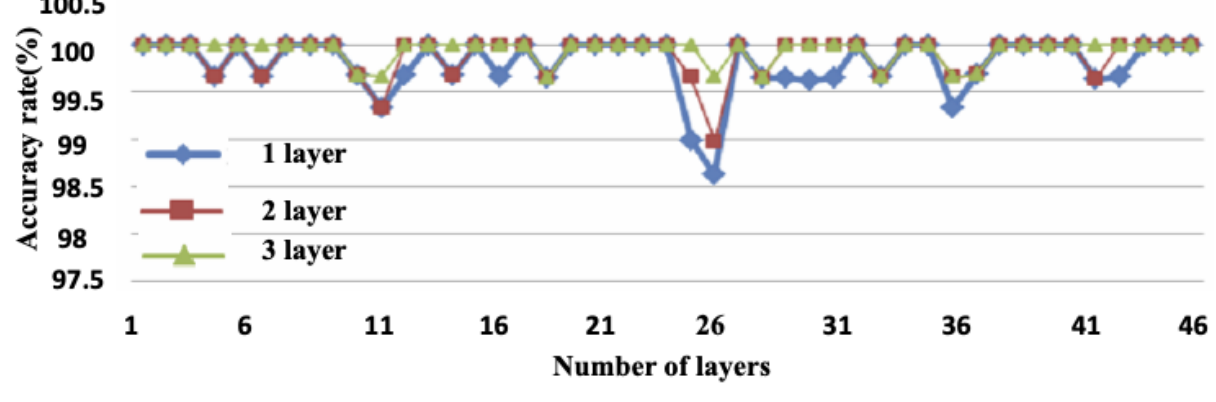
Figure 3. Classification accuracy of the Pendigit data set at different